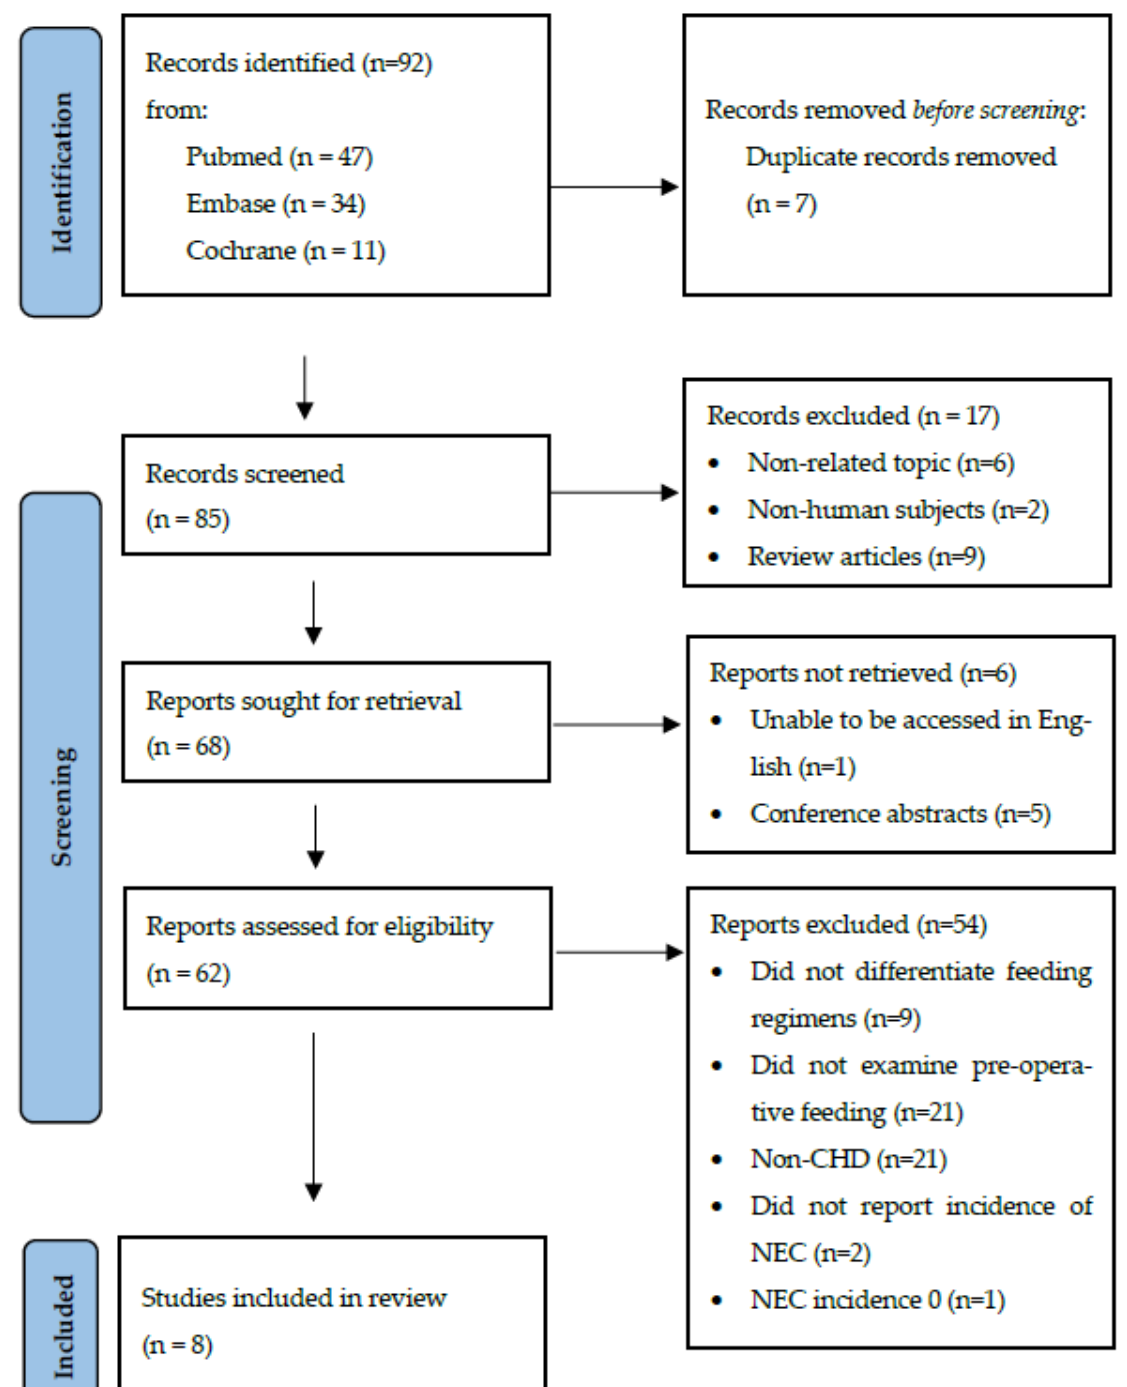
Figure 1. PRISMA flow diagram of search strategy. Terms: [Enteral feeding] AND [Cardiac Surgery] OR [congenital heart disease] AND [Necrotising Enterocolitis] AND [neonates OR infants].